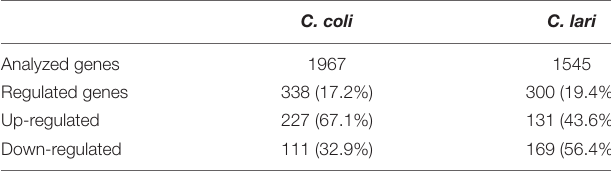
TABLE 1 | Gene expression profile by RNA sequencing of C. coli RM2228 and C. lari RM2100 after 30 min heat stress at 46 ◦ C compared to 37 ◦